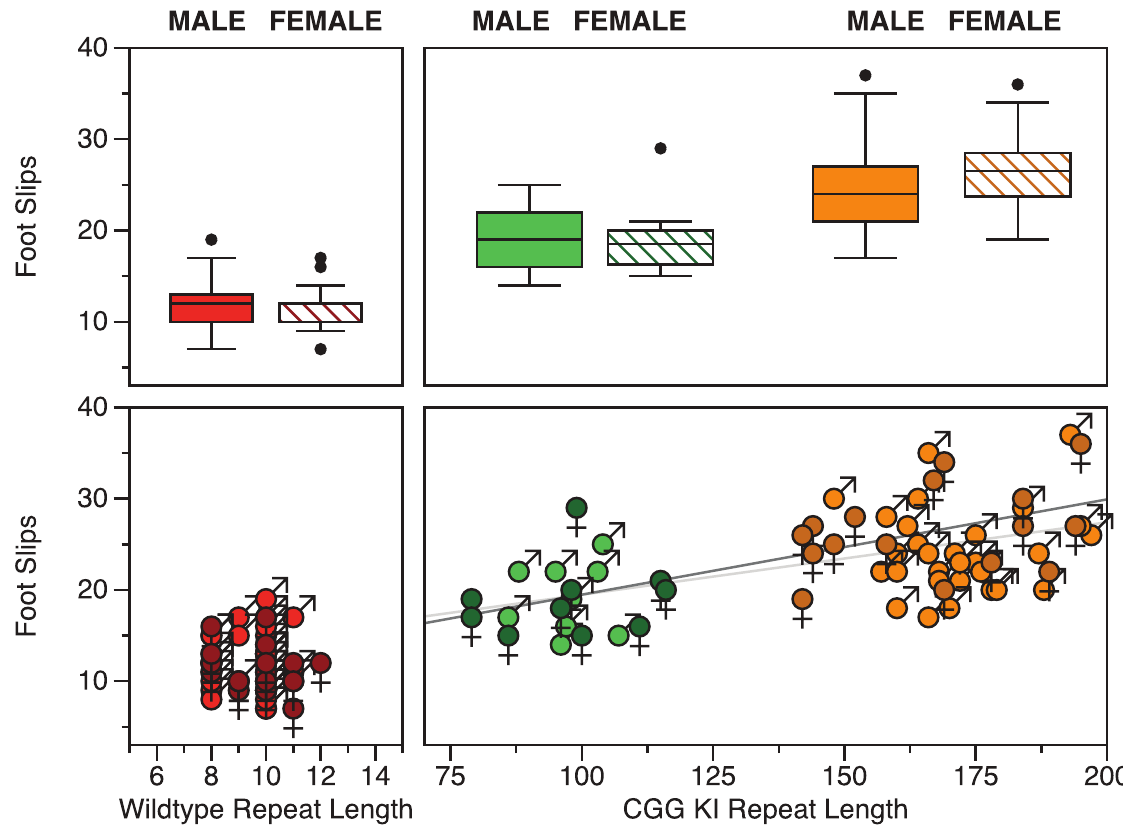
Figure 4. Performance of male and female CGG KI mice on the ladder rung task separated by sex. There were no effects of age present in the data. Data replotted from Hunsaker et al. , 2011 43